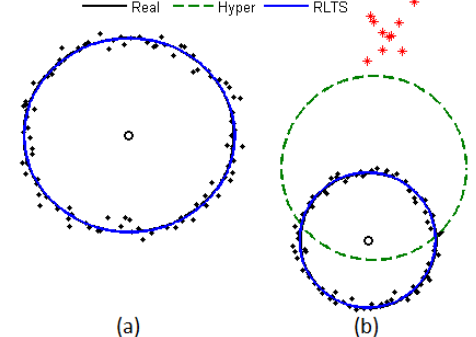
Figure 2. Influence of clustered outliers on circle fitting; (a) data without outliers, (b) data with outliers (red points)